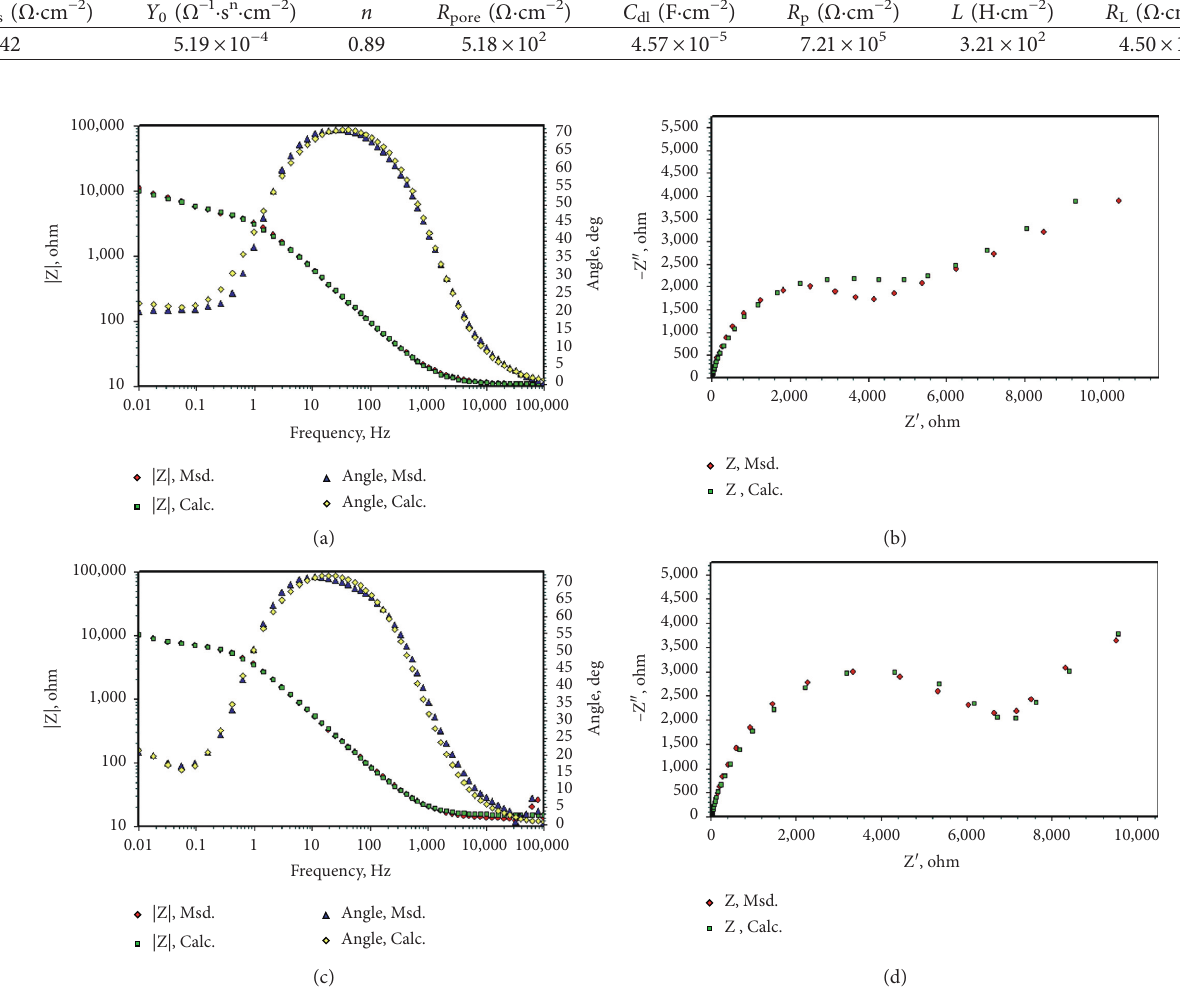
Figure 10: (a) Bode and (b) Nyquist curves of MAO coating after being immersed in 3.5 wt.% NaCl solution for 32 and 63